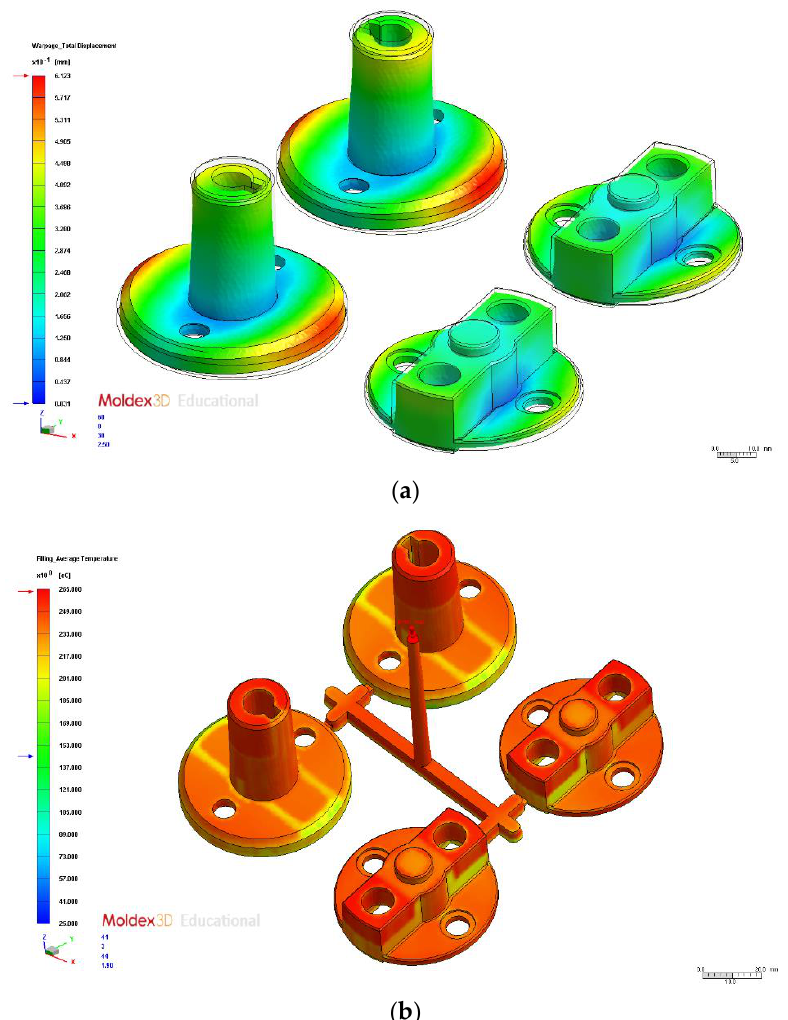
Figure 9. Warpage and Average Temperature Difference with Multiobjective Optimization. ( a ) Warpage with multiobjective optimization. ( b ) Average temperature difference with multiobjec- tive